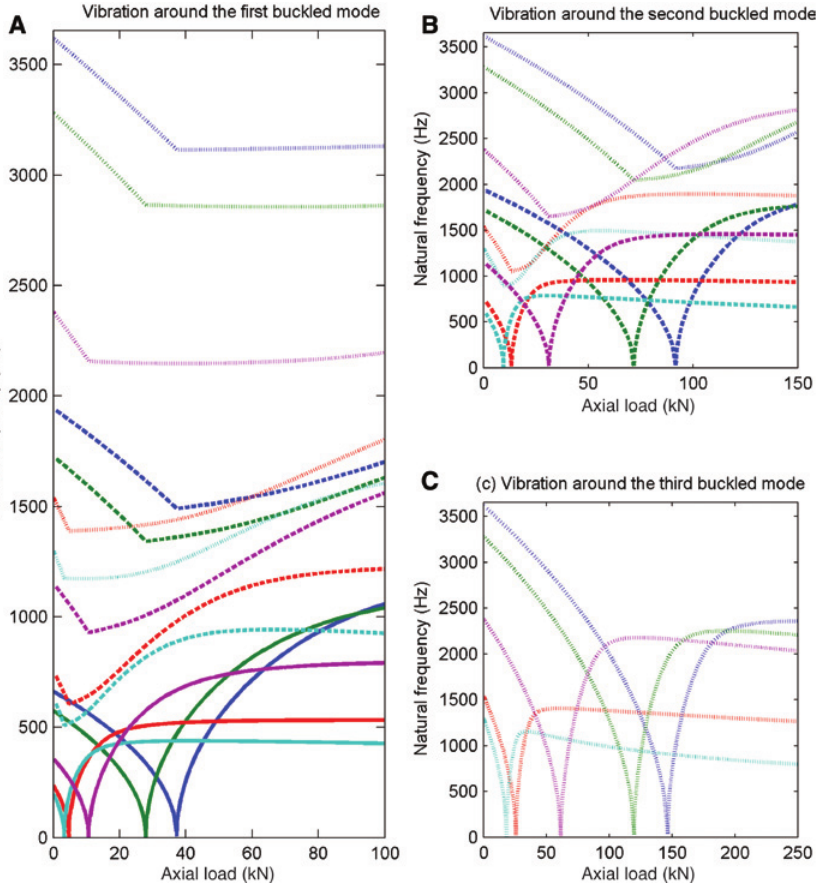
Figure 8 Variation of the natural frequency around the first three buckled configurations with the applied axial load for different laminates of an SC